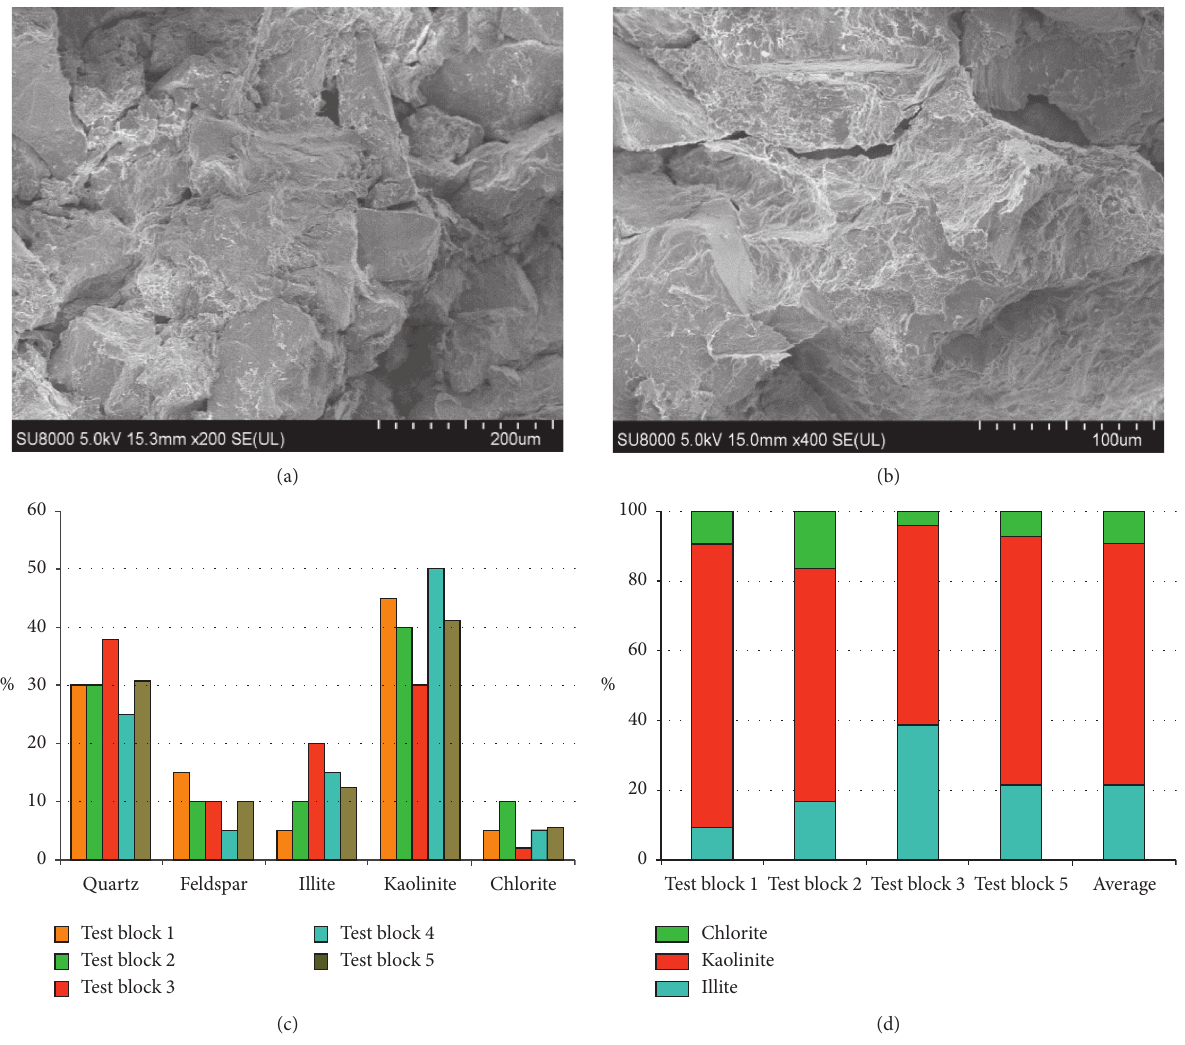
Figure 1: Microstructure and mineral component of rock: (a) × 200 multiples, (b) × 400 multiples, (c) XRD mineral composition, and (d) histogram of clay mineral composition accumulation.